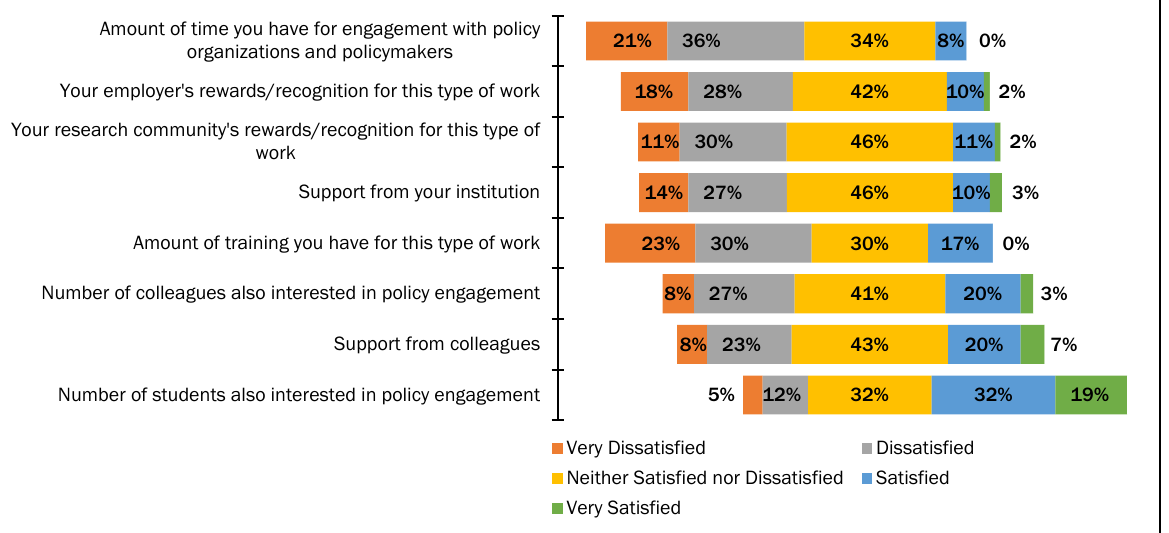
Table 3. Areas of Select Survey Questions Where Career Stage Influenced Responses Topic/Question RFA: Agroforestry (Table 2) RFA: Economics (Table 2) RFA: Human dimensions/decisionmaking (Table 2) RFA: Organic production systems (Table 2)